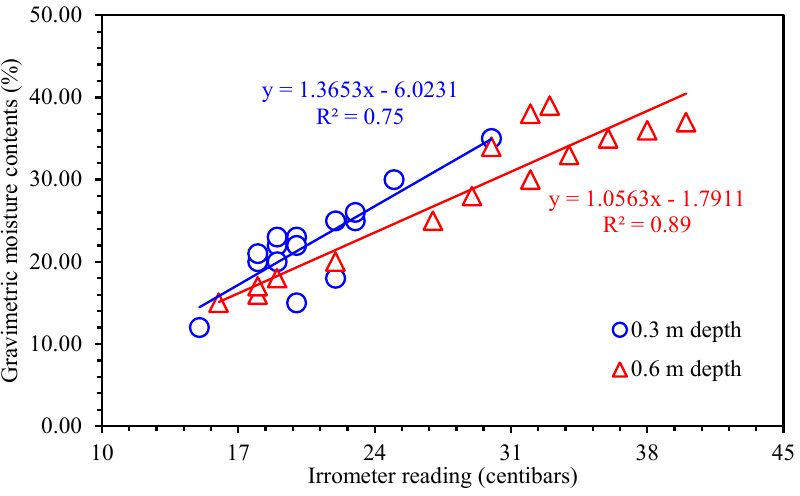
Figure 6. Calibration curves of irrometer sensors with gravimetric moisture contents at 0.3 and 0.6 m depths.